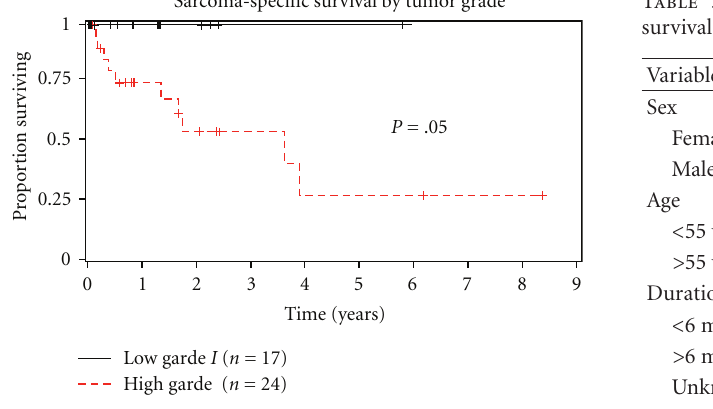
Figure 2: Sarcoma-specific survival of same 41 patients divided by tumor grade (low grade versus high grade).